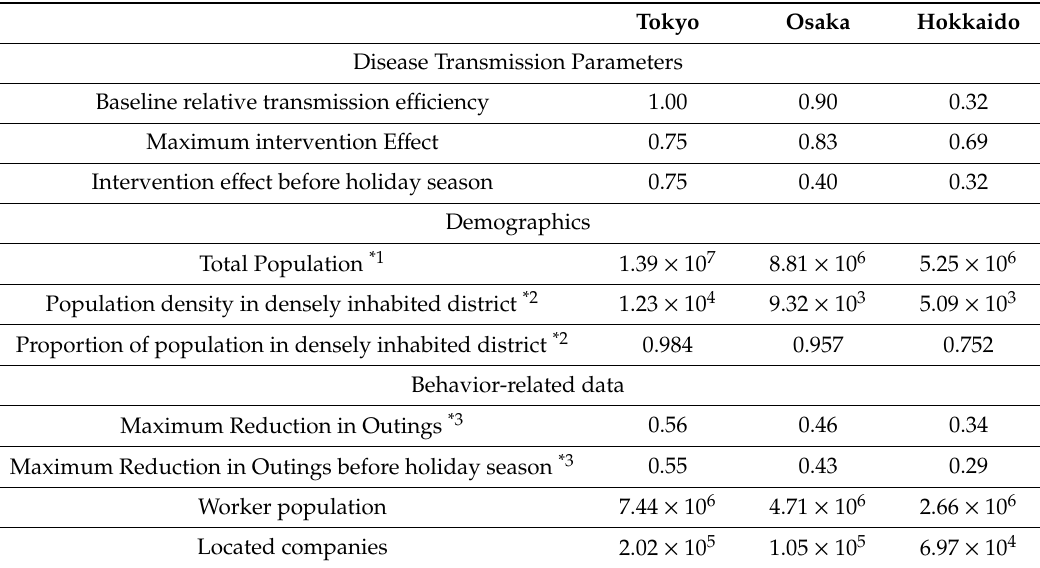
Table 2. Epidemic parameters and factors that potentially have a relationship to disease transmission.